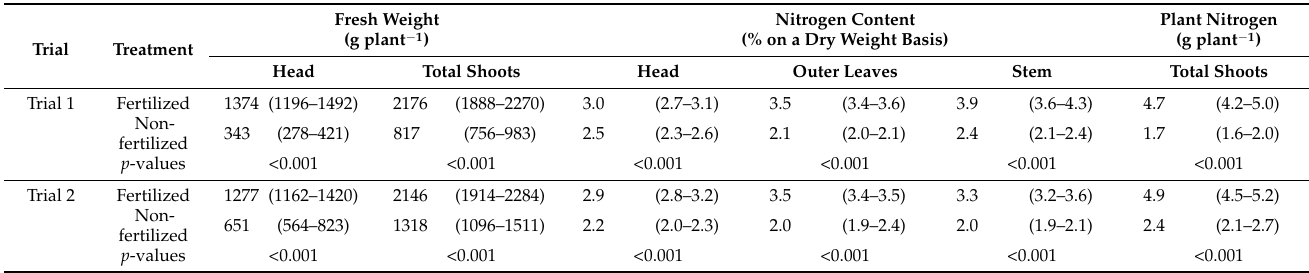
Table 1. Effects of fertilization on the yield of cabbage and nitrogen content (Trials 1 and 2). Values are the median values obtained from 25 replicates for fertilized plots and 6–7 replicates for non-fertilized plots (quartile range). p -values from the Mann–Whitney U test are